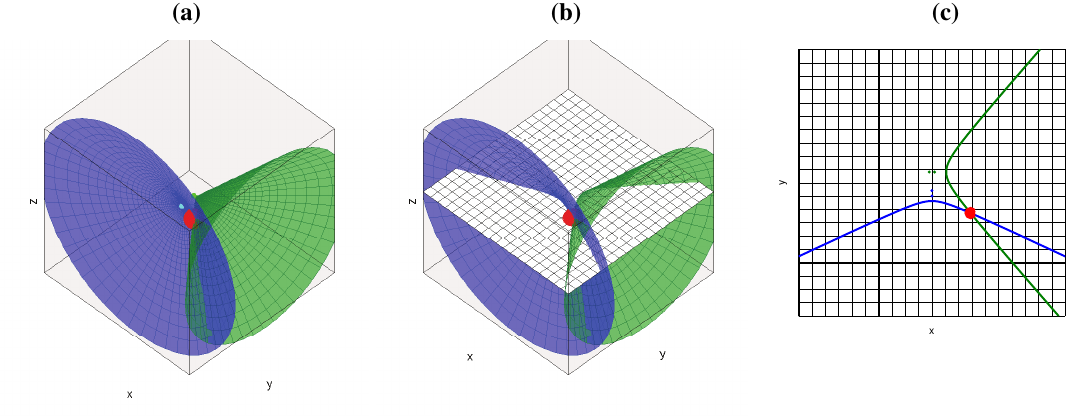
Figure 2. Geometric places generated for two microphone pairs and a single acoustic source (a) 3D hyperboloids; (b) 3D hyperboloids cut by a plane; (c) Resulting 2D hyperbolas (cutting hyperboloids by a